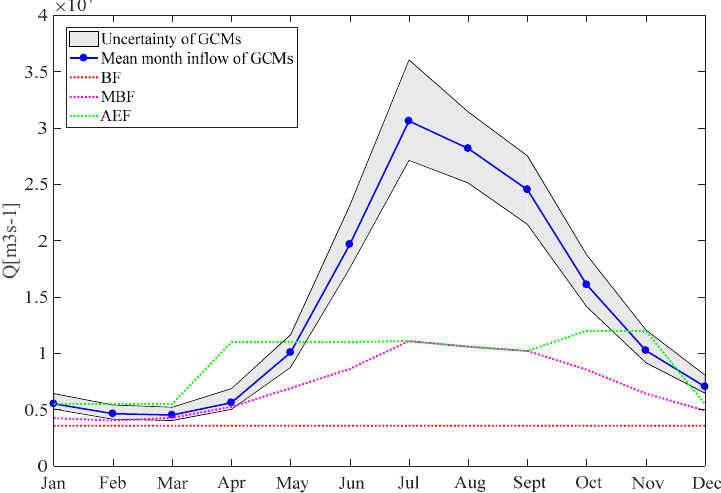
Figure 5. Projected (2021–2082) mean monthly inflow (m 3 /s) generated by 25 GCMs (BF: basic flow; MBF: maintenance basic flow; AEF: appropriate environmental flow).